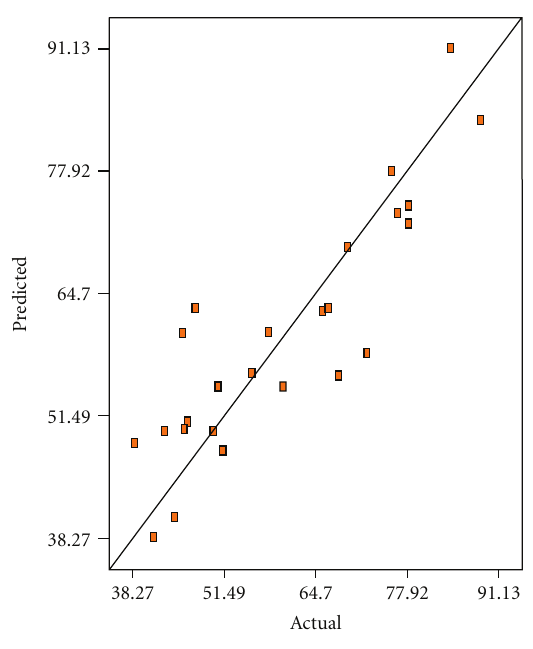
Figure 3: Predicated versus actual plot of Y (OLHYOOD).